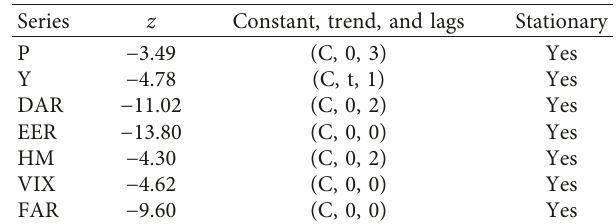
Table 2: Unit root test.